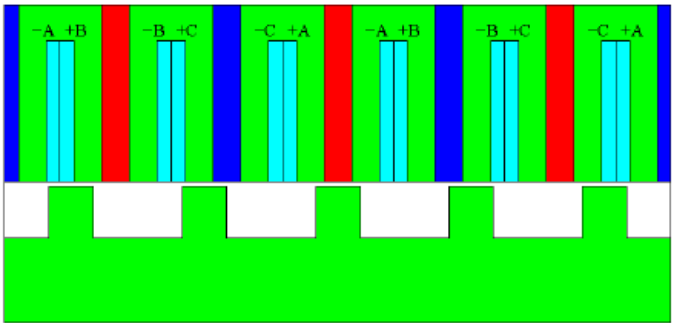
Figure 2. The AFSPM winding configuration ABC-ABC.